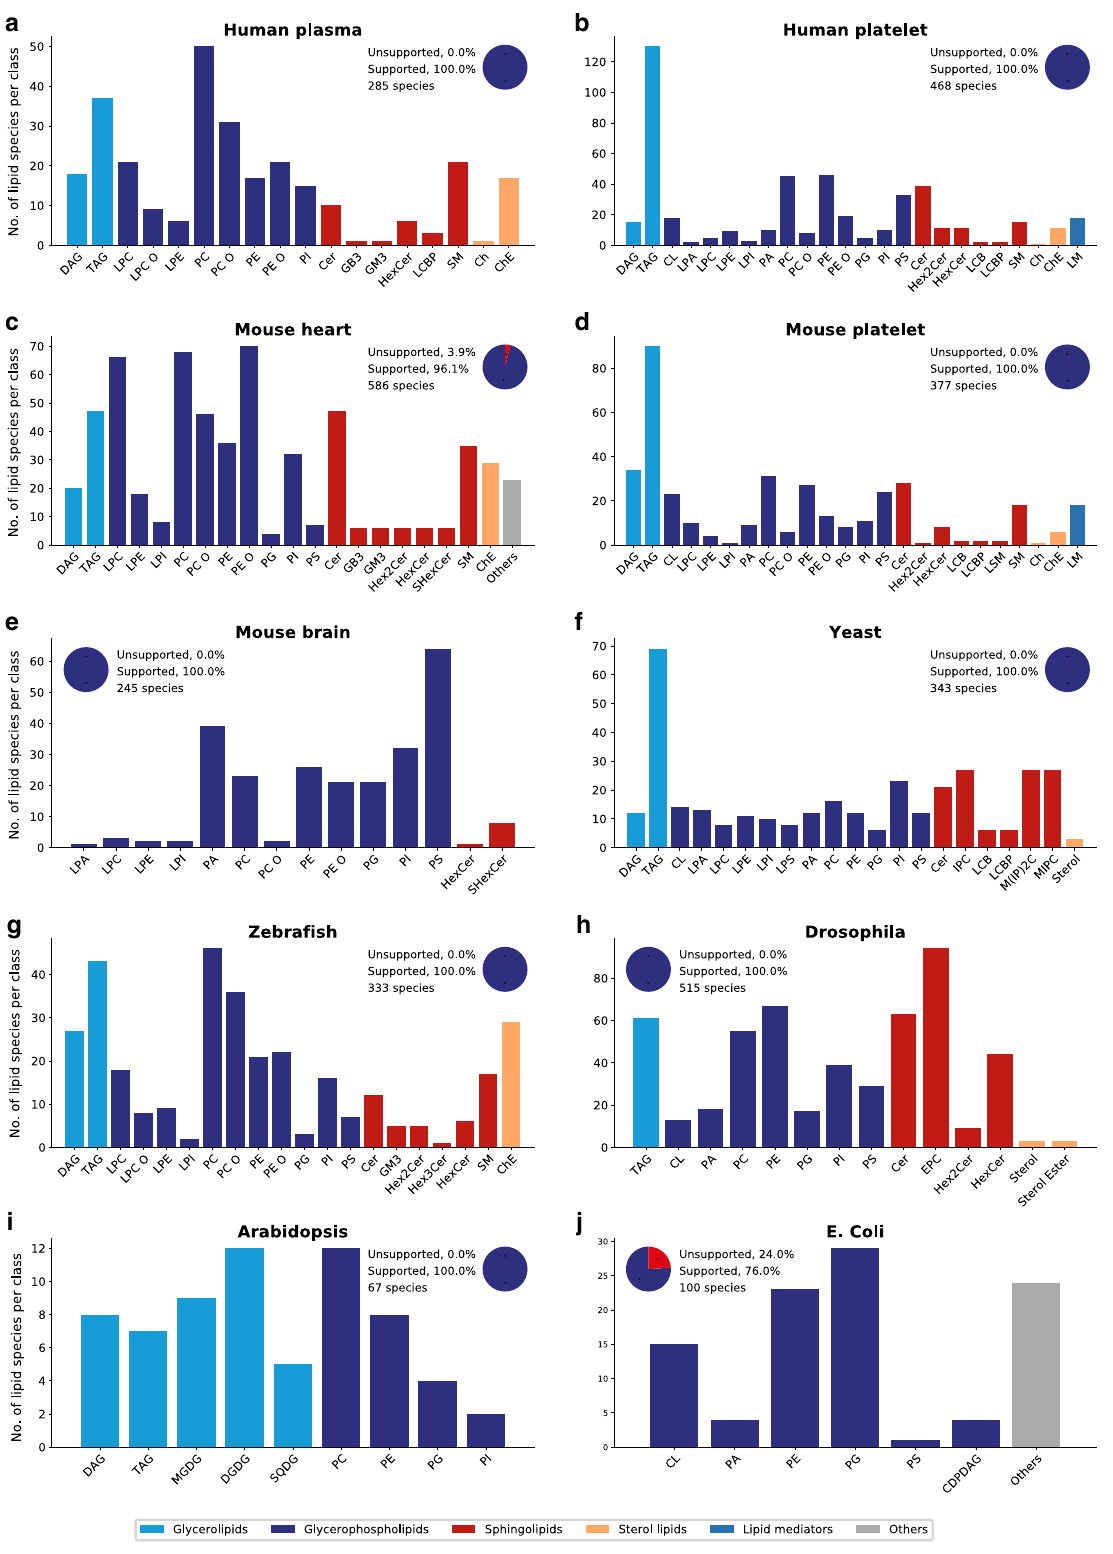
Fig. 4 Lipid distribution and lipidome coverage of LipidCreator in different model organisms. a – j Numbers of lipid species per lipid class within different organisms. A list with all unsupported lipid classes within this experiment is available in Supplementary Note 1 and in Supplementary Data 1. The latter table further contains detailed descriptions of all lipid name abbreviations and the lipid classes supported by LipidCreator. Source data are provided as a Source Data fi